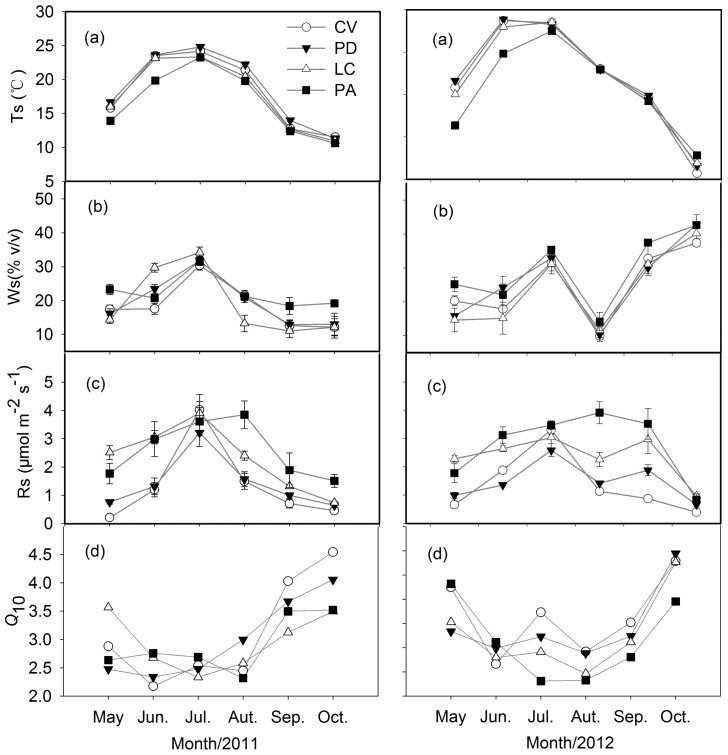
Seasonal variations of soil temperature (Ts), soil water content (Ws), soil respiration rate and Q10 at four communities during the 2011–2012 growing seasons.Error bars represent standard errors of the mean. The site codes were shown in Table 1.